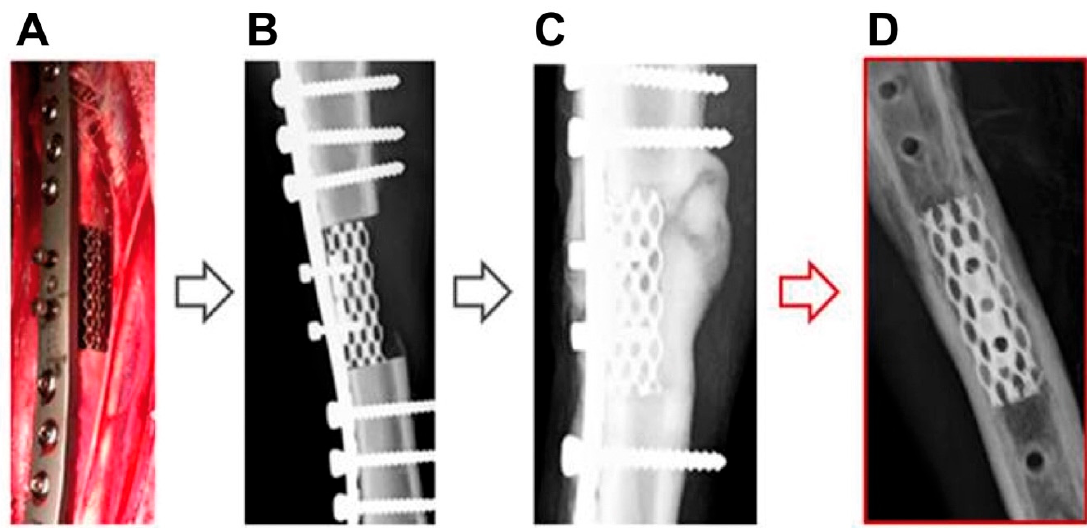
Figure 4. ( A ) Photograph of the operation field in an animal of the experimental group, showing the tibia and the 5-cm-long macroporous scaffold (asterisk). The osteosynthesis plate is anchored with screws to both the bone (big arrows) and the scaffold (small arrows). ( B , C , D ) X-ray images of the sheep-operated tibiae taken right after surgery ( B ), 2 months after surgery ( C ), and 9 months after surgery ( D ).